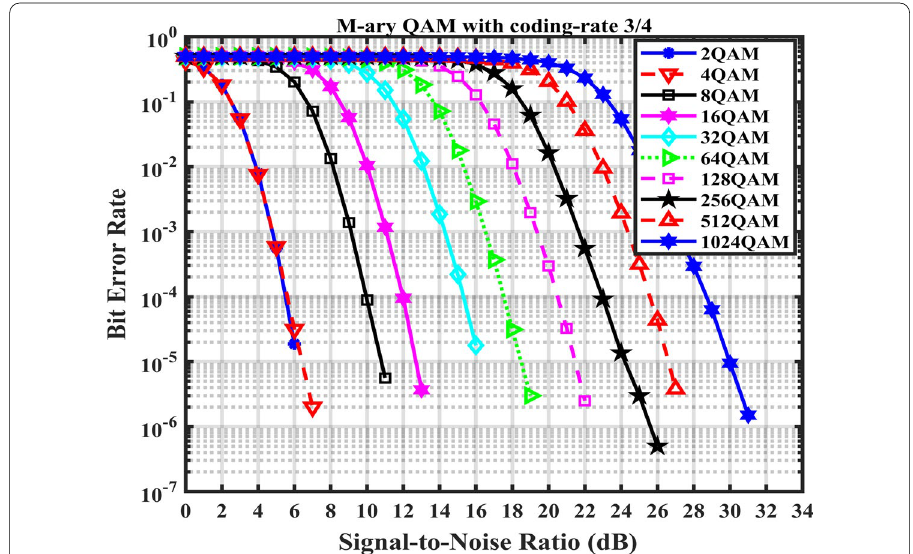
Fig. 14 BER versus SNR for different M-ary QAM with 3/4 code rate. This graph depicts the performance of different M-ary QAM with 3/4 code rate combination. The performance is described in terms of BER versus